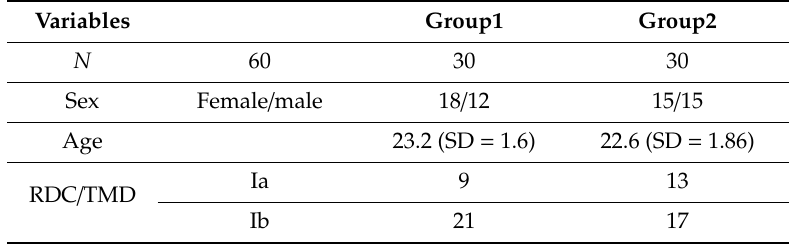
Table 1. Structure of Group I and Group II main descriptive